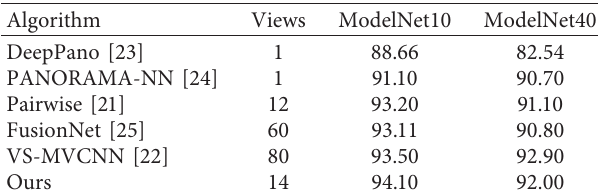
Table 5: Classification accuracy compared with other methods